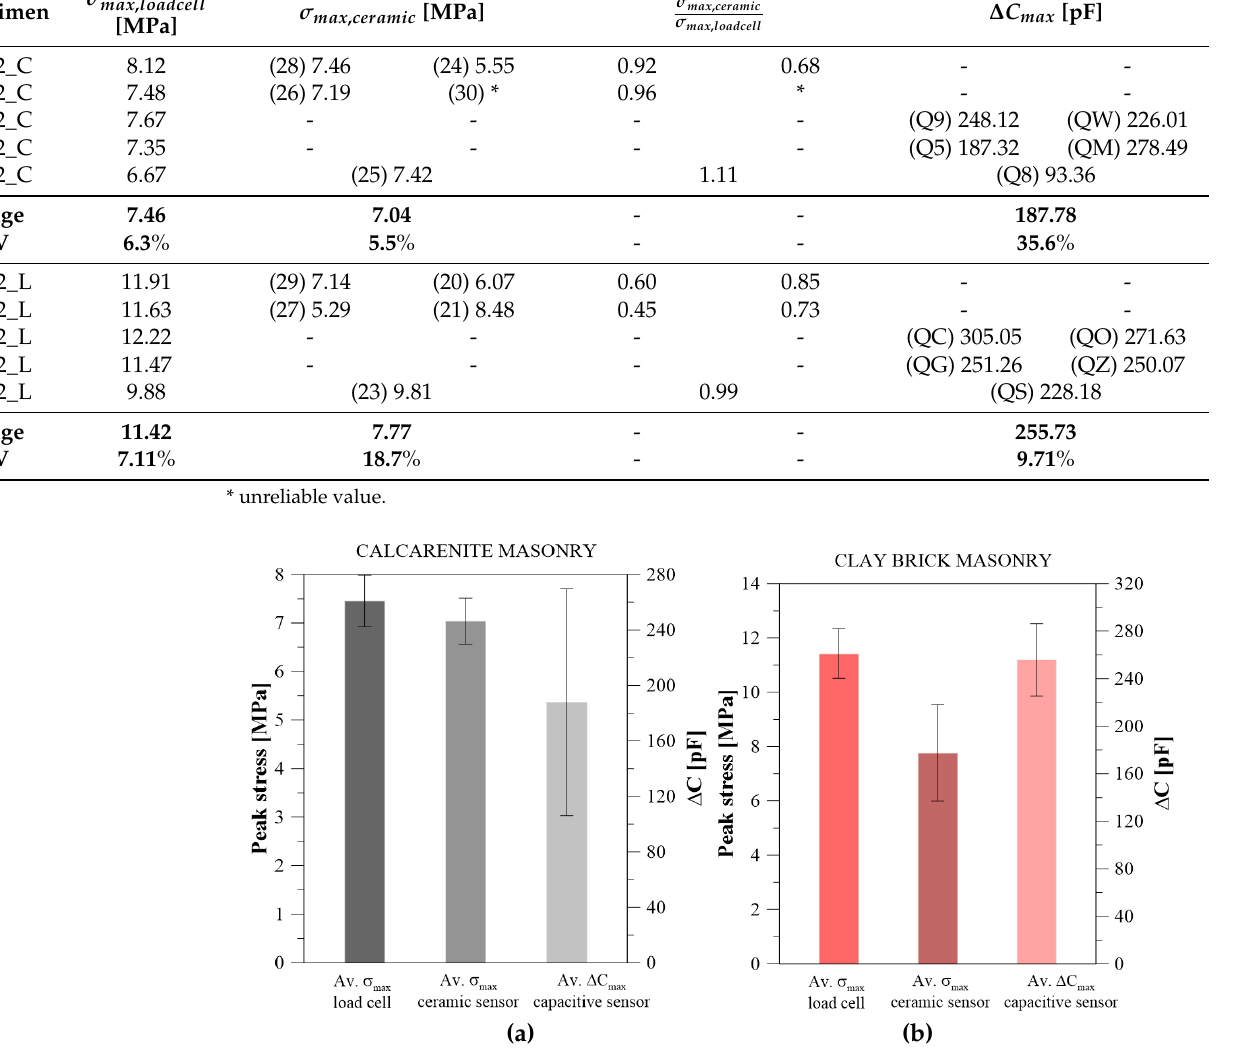
Figure 20. Average and standard deviation values, according to post-installation system P2: ( a ) calcarenite masonry; ( b ) clay bricks